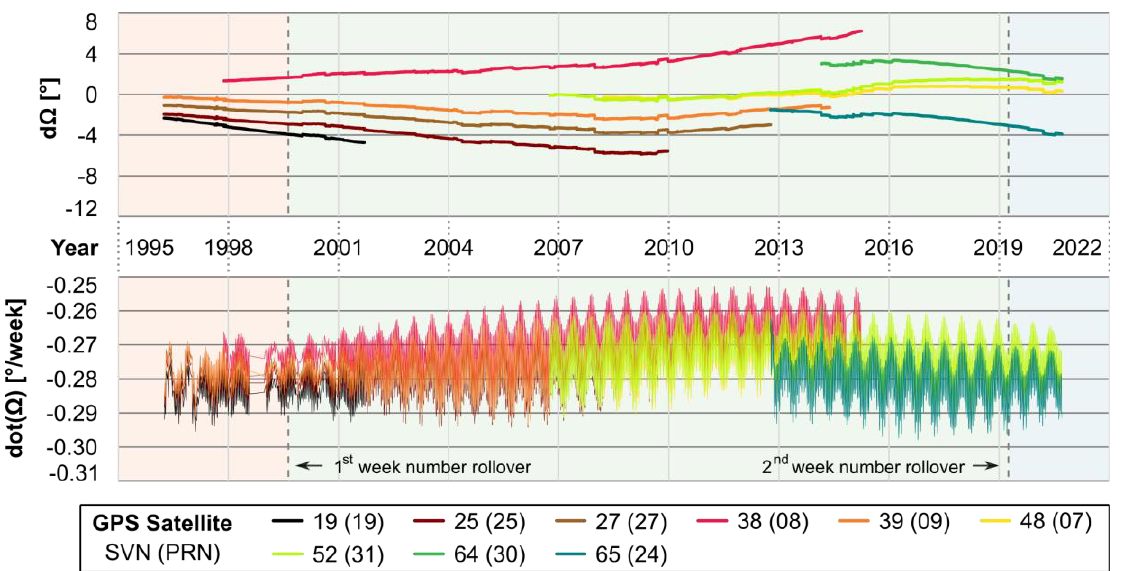
Figure A1. Separation of satellite ANs from the hex-LS-estimated position of the OP A AN with satellite dot(Ω) values. Table A2. Descriptive parameters of the OP B satellites.